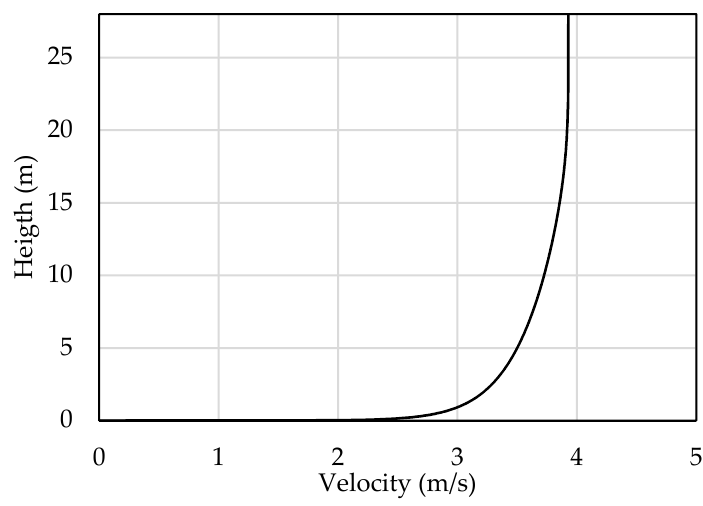
Figure 4. Inlet velocity profile in the function of the height of the domain.